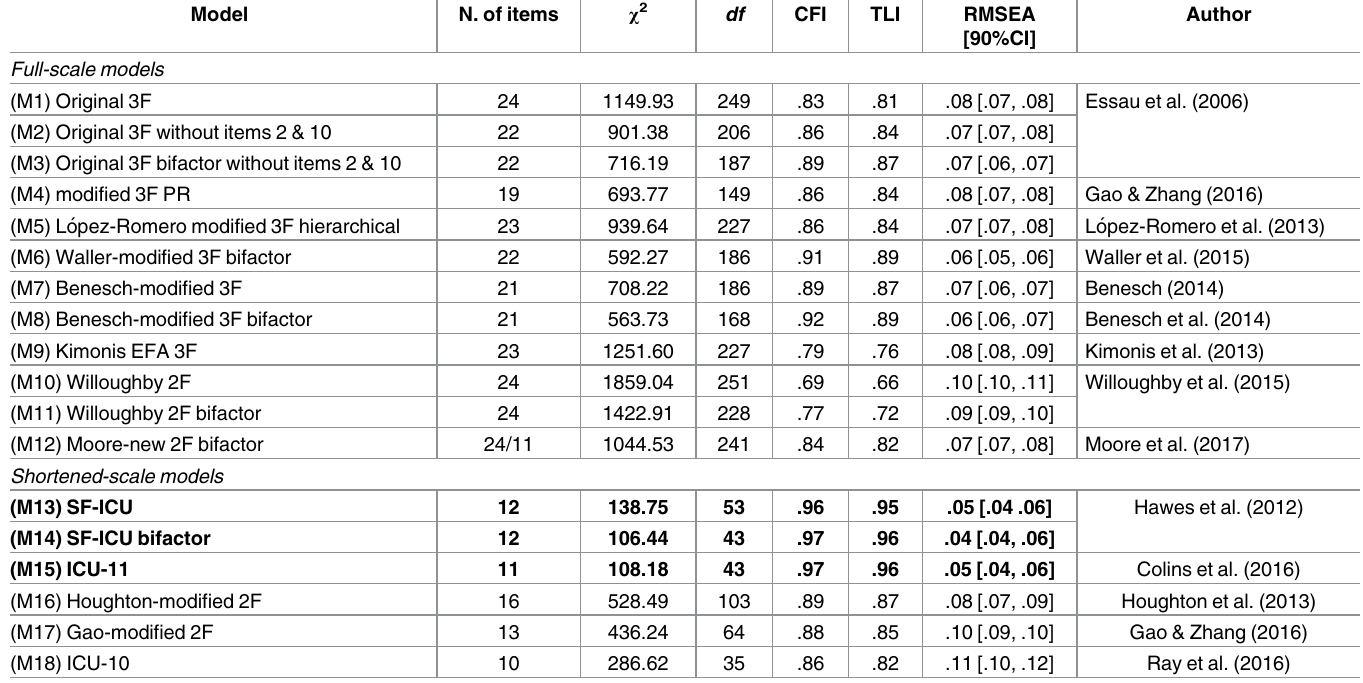
Table 3. Goodness-of-fit indices for tested models in the confirmatory factor analyses. Model N. of